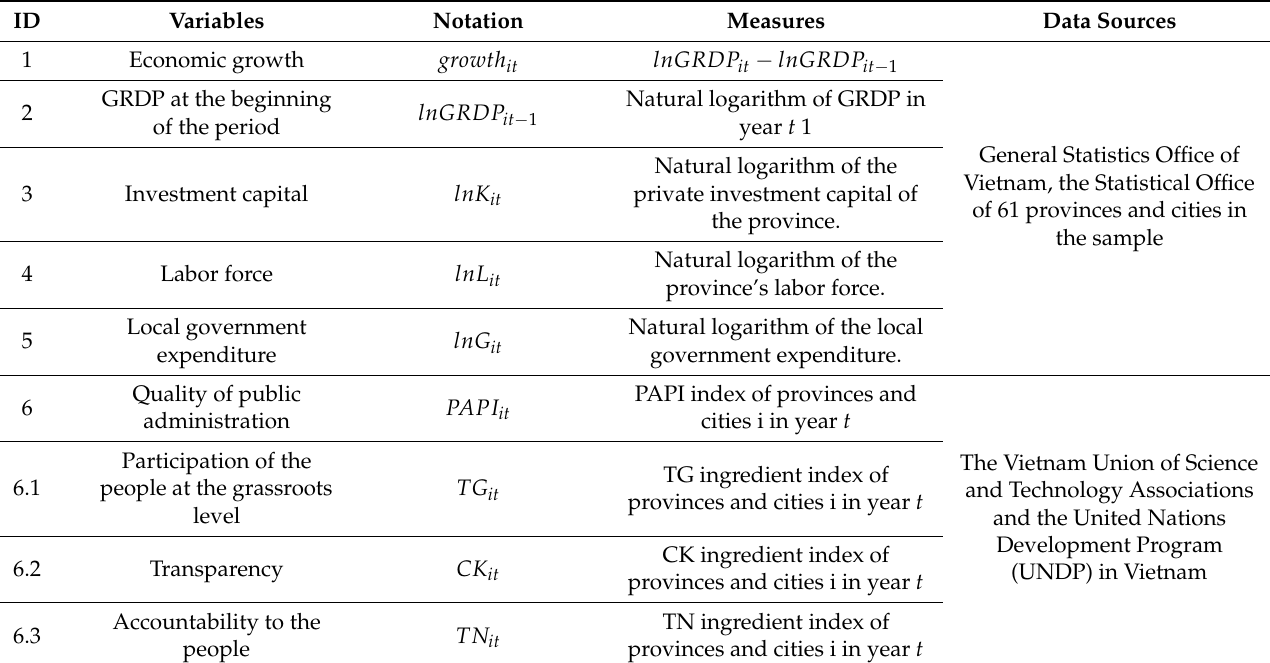
Table 1. Summary of variables in the